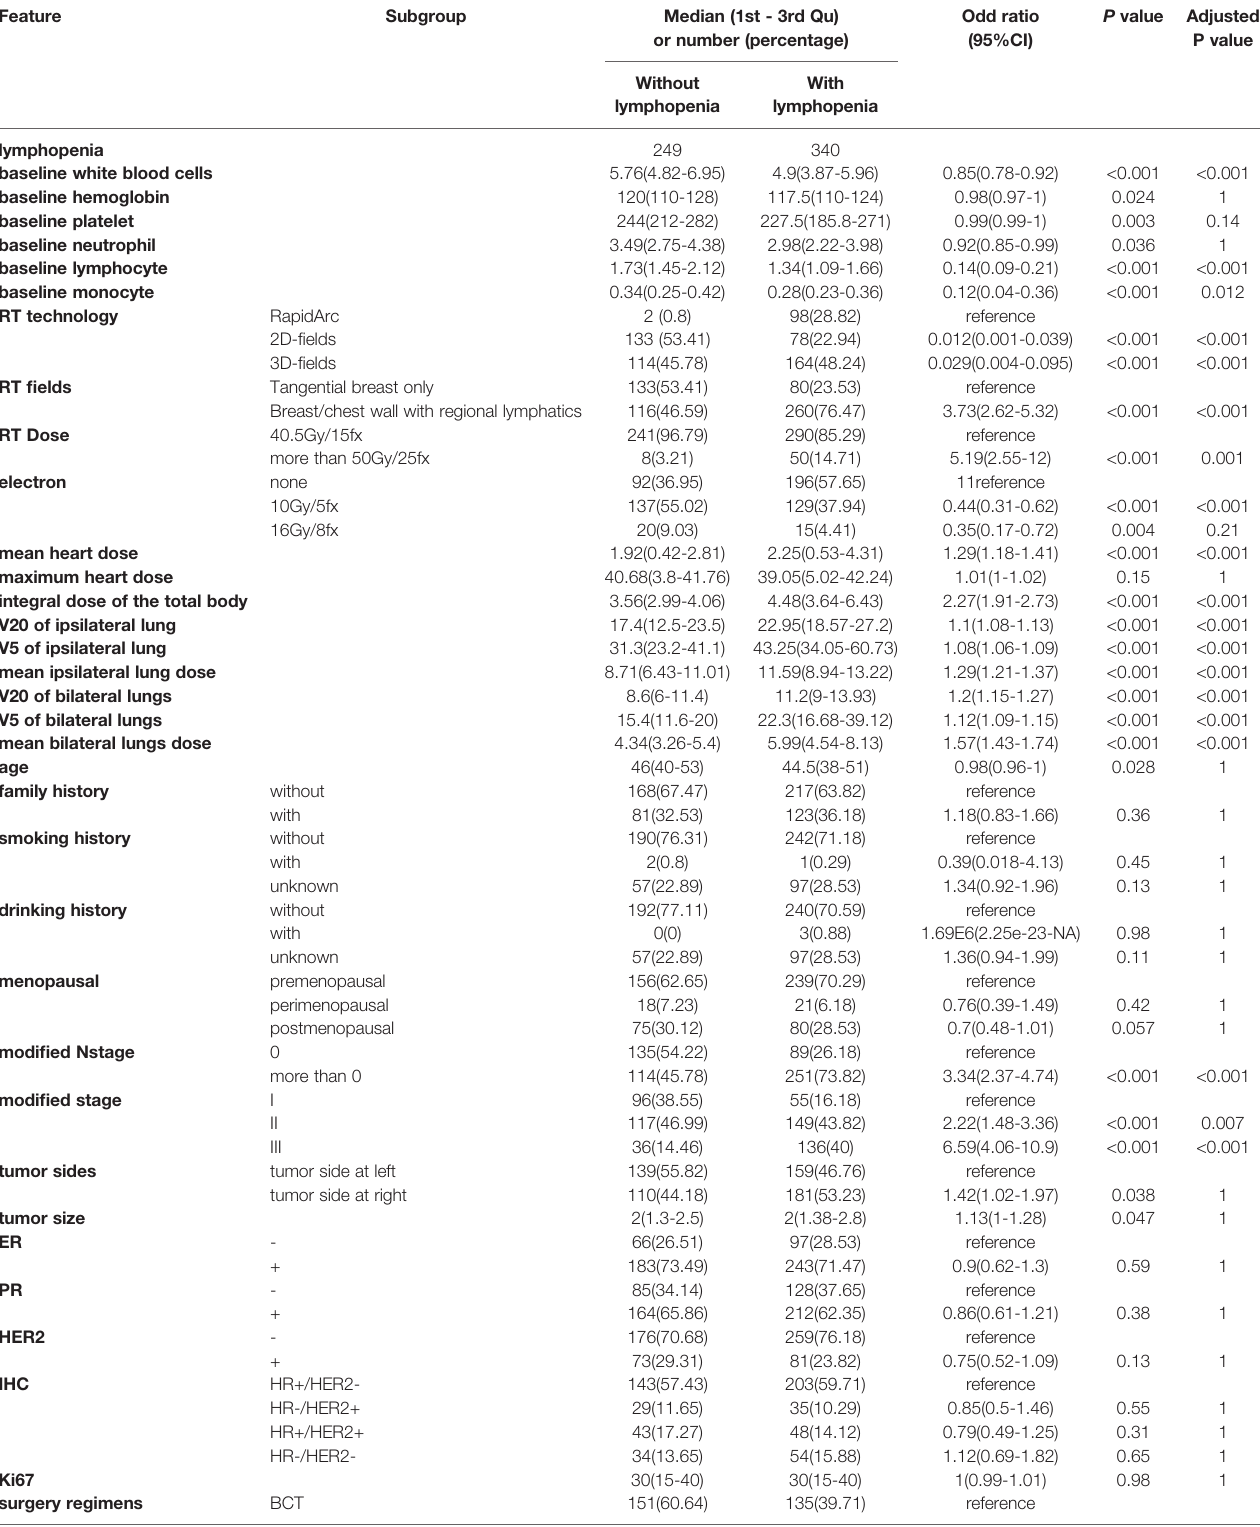
TABLE 1 | The characteristics of breast cancer patients in Testing cohort (total 589 patients), continues features are shown as median (1st to 3rd quantile) and classi fi ed features are shown as numbers (percentage).